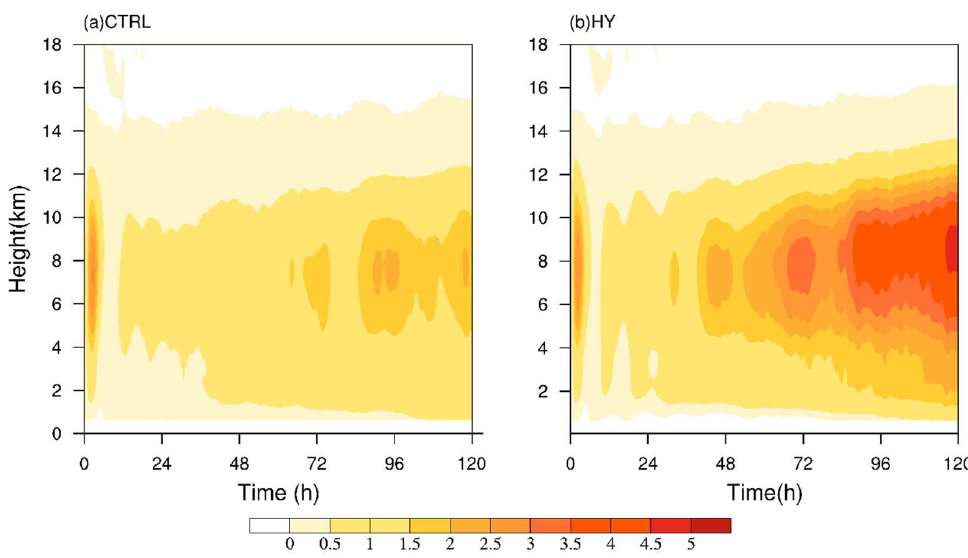
Figure 14. Horizontal distributions of the simulated vertical winds from 3 km to 15 km for ( a, b, c, d ) CTRL and ( e, f, g, h )